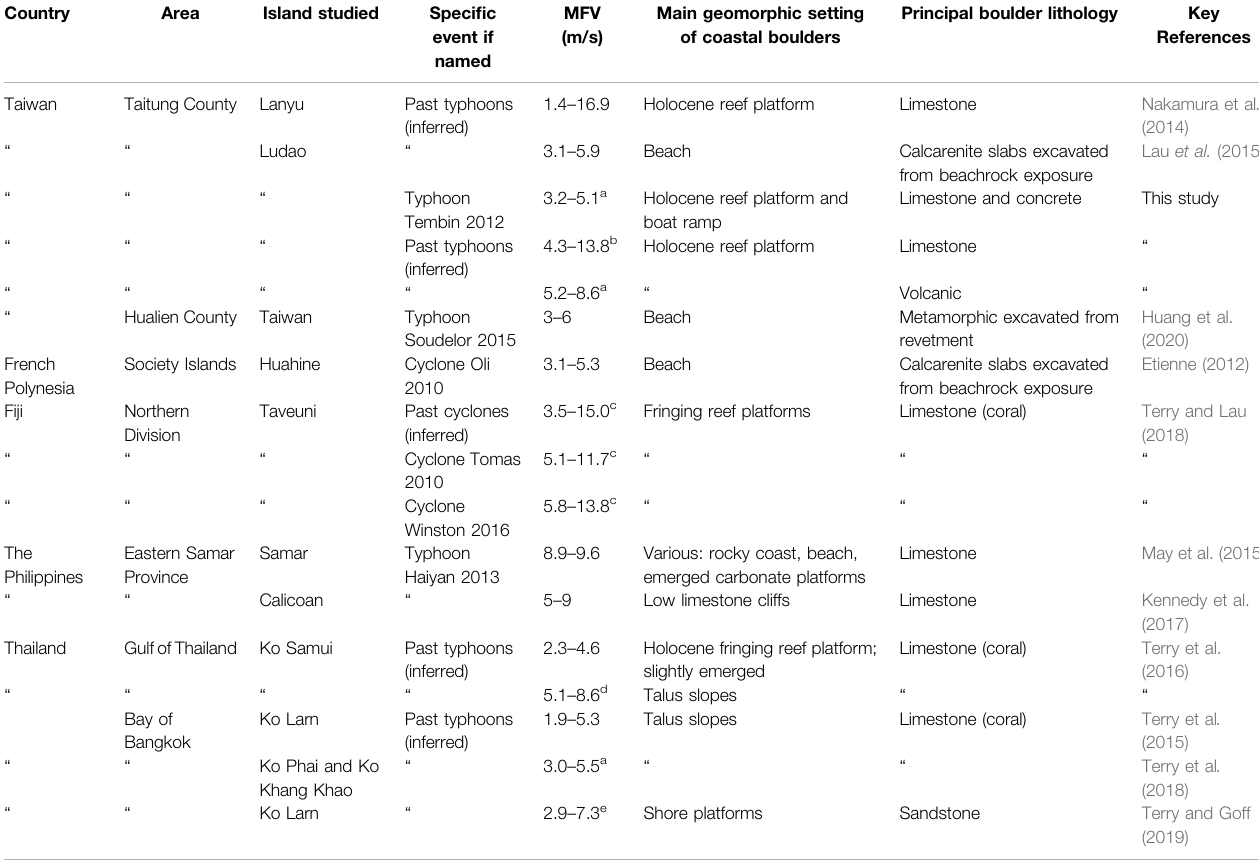
TABLE3| Comparisonofonshore fl owvelocitiesgeneratedbytyphoonsandtropicalcyclonesacrosstheAsia – Paci fi cregion,asmodelledfromthecharacteristicsofwave- transported coastal